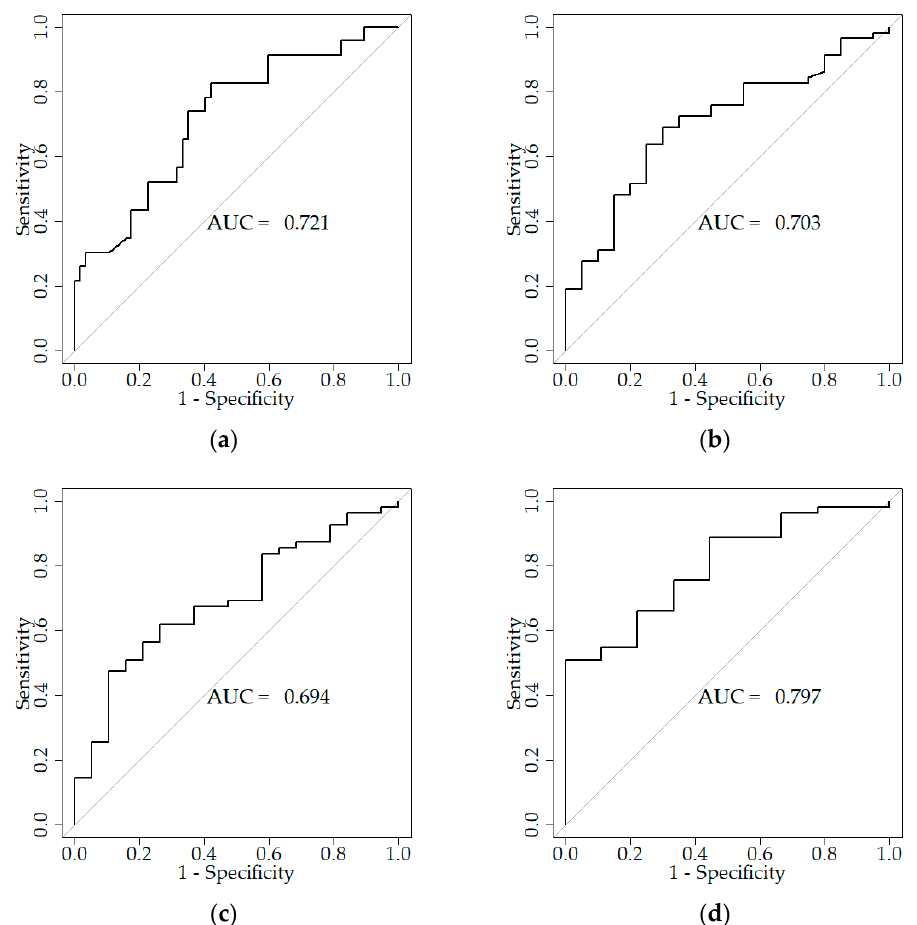
Figure 2. ROC curves reflecting the sensitivity and specificity of carbonyl groups concentration measurements for patients with a favourable functional outcome: ( a ) CG < 4.5 h; on admission (cut-off point ≤ 236.38 U/mL, sensitivity 82.6%, specificity 57.9%), ( b ) CG < 4.5 h; after discharge (cut-off point ≤ 256.05 U/mL, sensitivity 69.0%, specificity 70.0%), ( c ) CG < 4.5 h; after three months (cut-off point ≤ 198.22 U/mL, sensitivity 47.2%, specificity 89.5%), ( d ) CG < 4.5 h; after a year (cut-off point ≤ 198.22 U/mL, sensitivity 50.9%, specificity 100%).